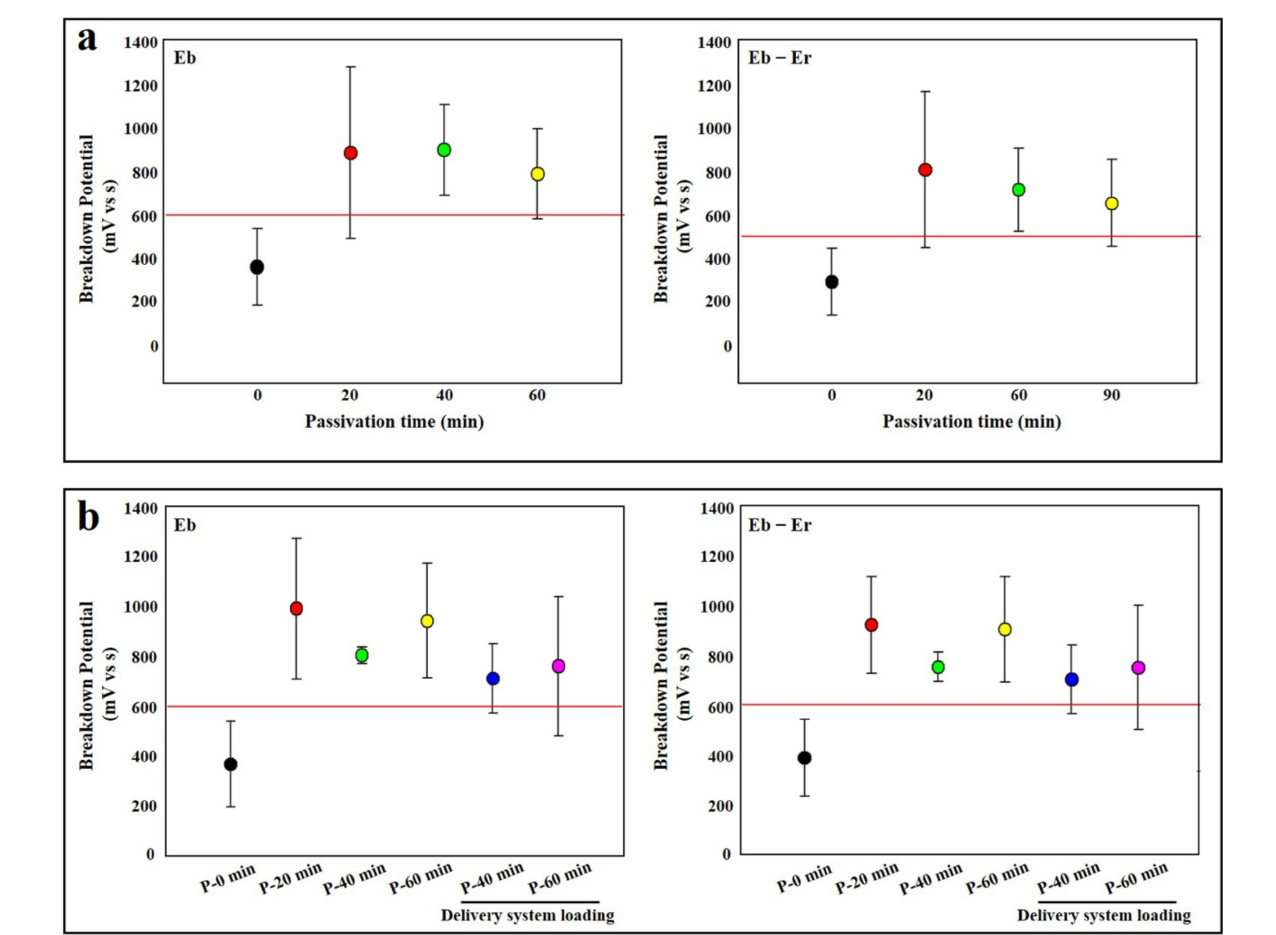
Figure 5. Passivation of stent after air furnace. ( a ) Fully covered stent and ( b ) double-covered stent. Red lines indicate acceptance criteria in this study as mentioned in Materials and Methods